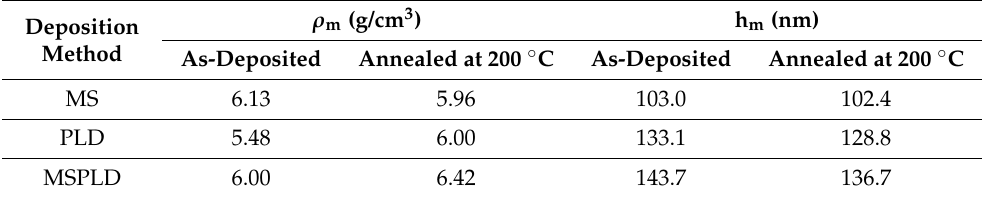
Table 2. The mean mass density ( ρ m ± 0.12 g/cm 3 ) and the average thickness (h m ± 5 nm) of the GST-225 thin